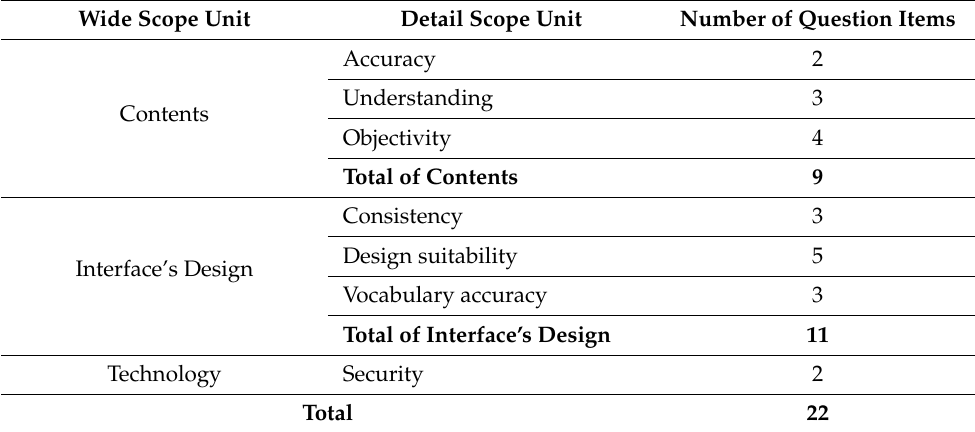
Table 1. Question items for the mobile application usability evaluation .